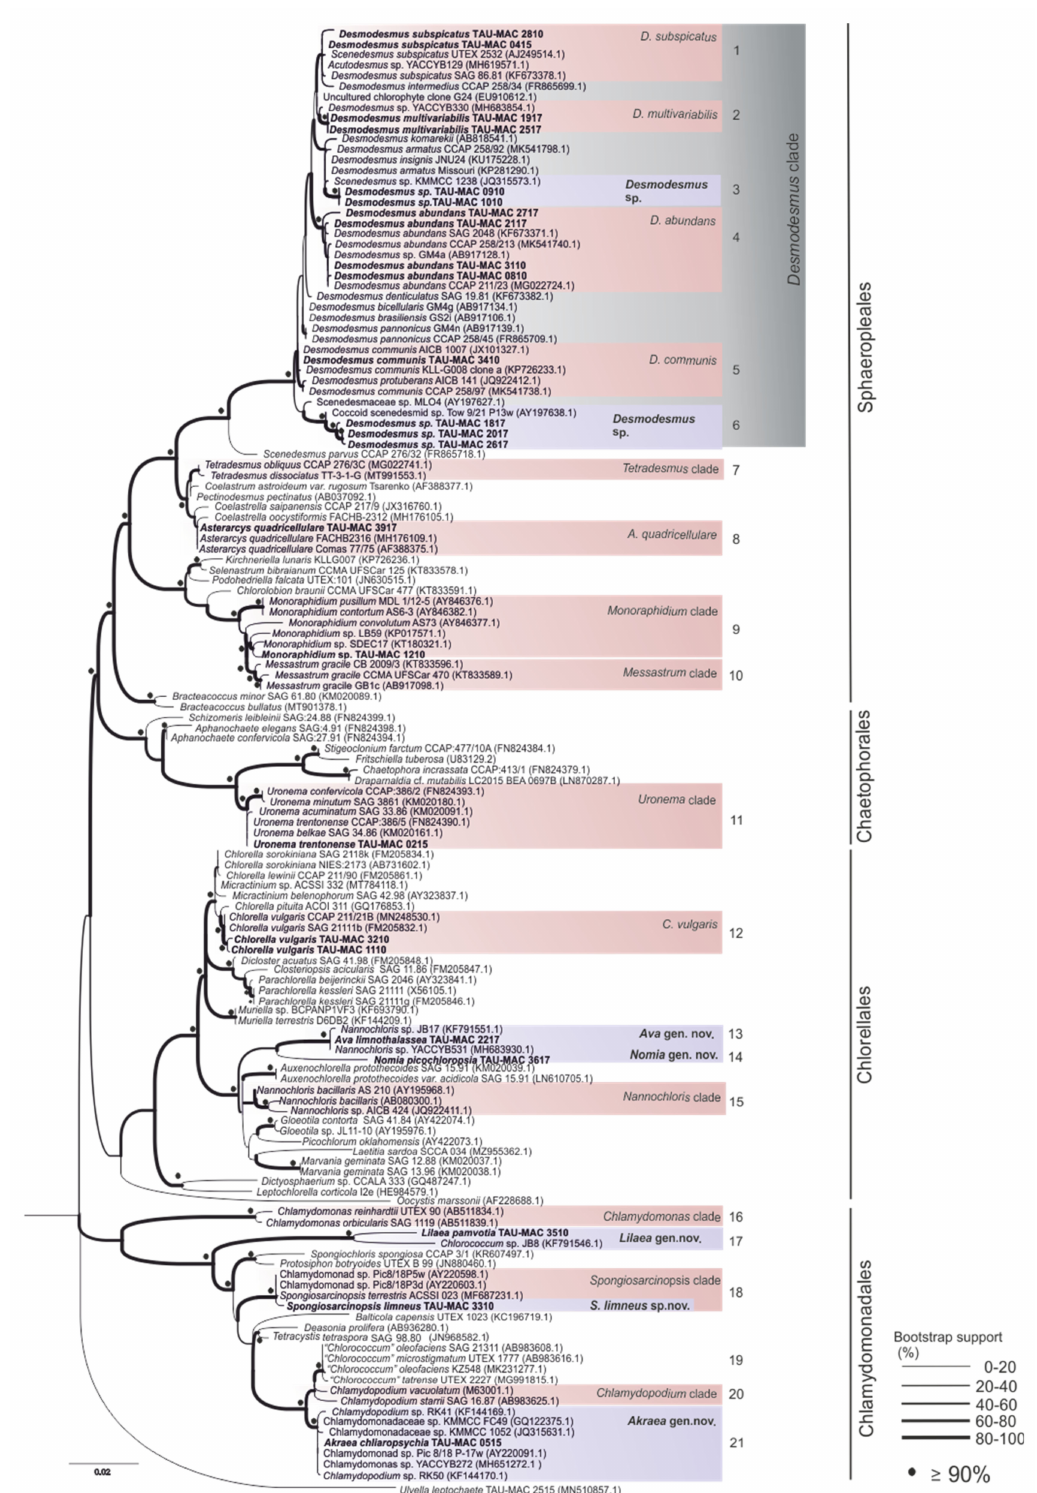
Figure 1. Phylogenetic tree of relationships of the TAU-MAC green algae strains based on 18S rRNA (c. 1700 bp) gene including Chlorophyceae and Trebouxiophyceae. Line thickness at branches represents bootstrap support values (bootstrap support for ML and MP analysis). The numbers in parentheses are GenBank accession